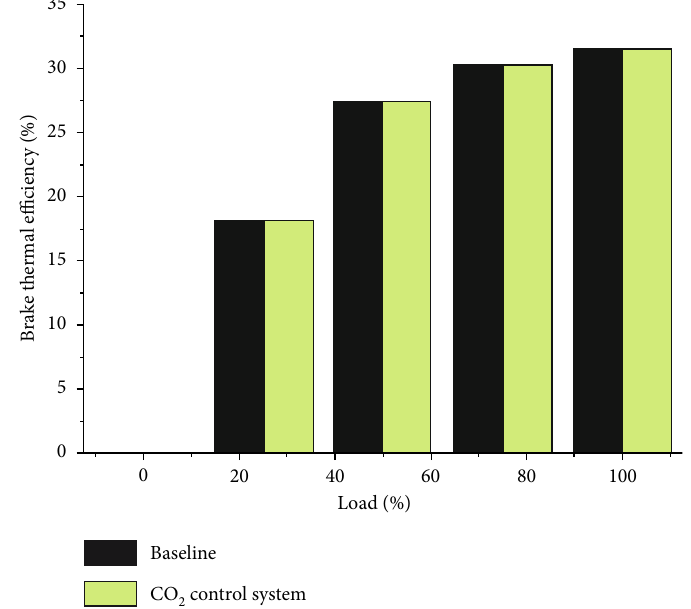
Figure. 7: Variation of brake thermal e ffi ciency with respect to engine load.